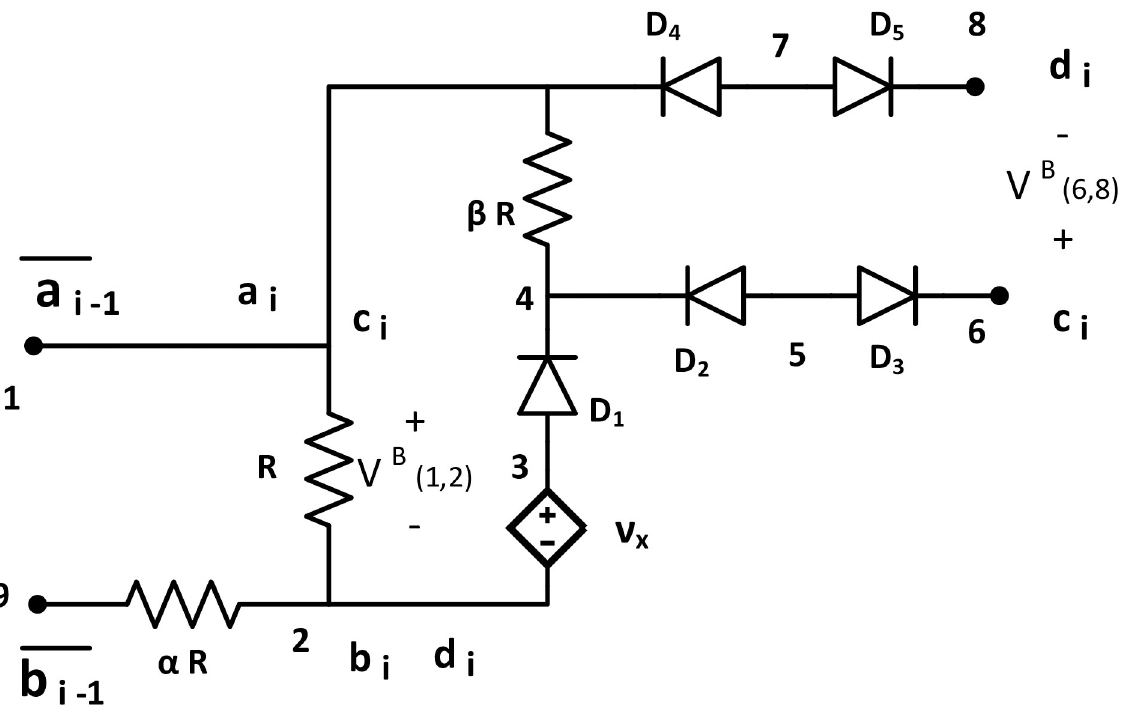
Fig 3. Circuit tile B. Tile B (Circuit Tile) consists with three resistors ( R , α R , and β R ), one dependent voltage source V D 1 , D 2 , D 3 , D 4 , D 5 with τ = 0. It has one input node terminal at node {1, 9} and two output node terminals at node {1, 2} and node {6, 8}. Glues: ; c ; � a g , g (2) = { b , d }, g (6) = c , g (8) = d , and g ð 9 Þ ¼ � b , where i = 2, 3, ... g ð 1 Þ ¼ f a i i i i i i i (cid:0) 1 i (cid:0) 1